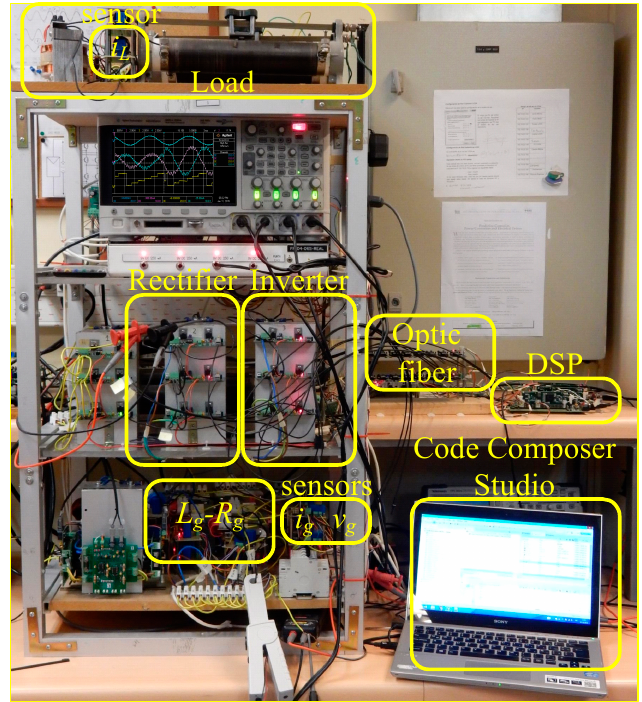
Figure 5. Laboratory prototype .